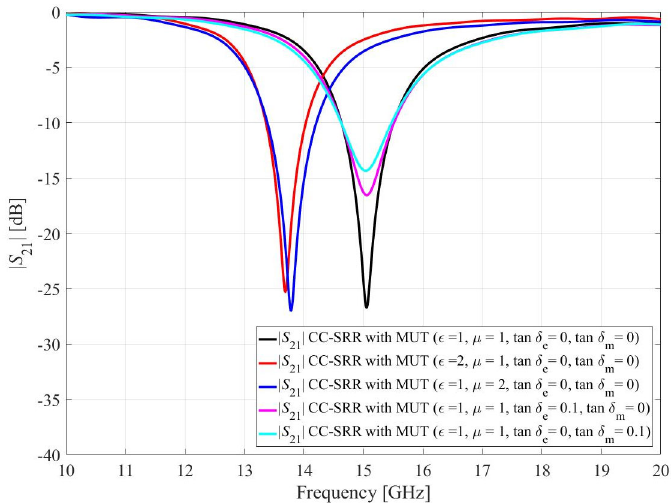
Figure 7. Simulated transmission coefficients ( S 21 ) of the CC ‐ SRR due to interaction with the sample under test (SUT) by perturbing one of SUT’s electromagnetic parameters.